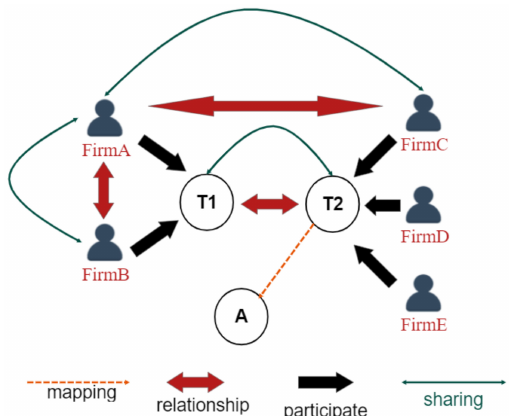
Figure 8. Example of project alliances data sharing.